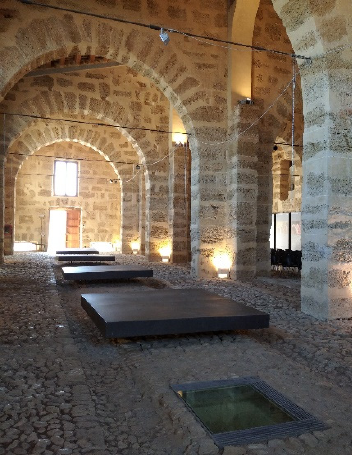
Figure 2 . Interior of the “ Real Cantina Borbonica ”: the right